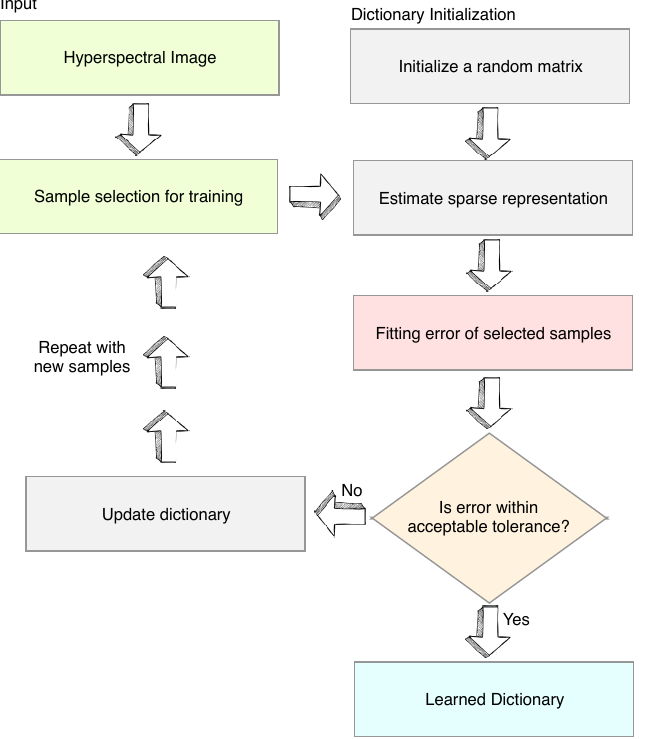
Figure 1. Flow diagram of the classic spare coding dictionary (C-SCD)